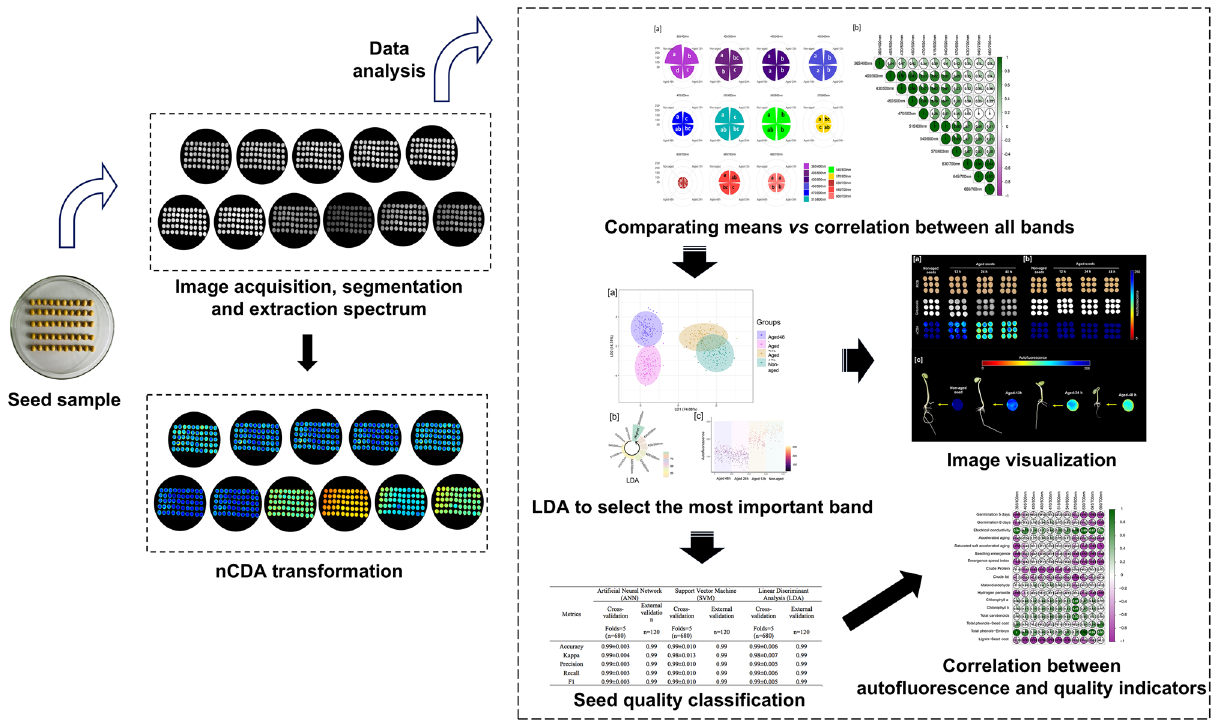
Figure 8. Overall flowchart of the main procedures for soybean seed quality classification based on autofluorescence-spectral